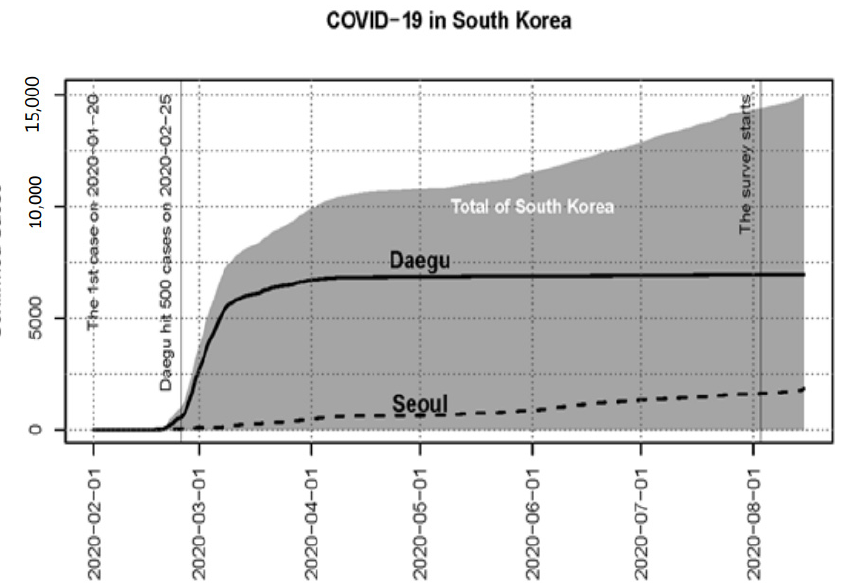
Figure 2. COVID-19 accumulated confirmed cases in South Korea in the context of the survey time point.